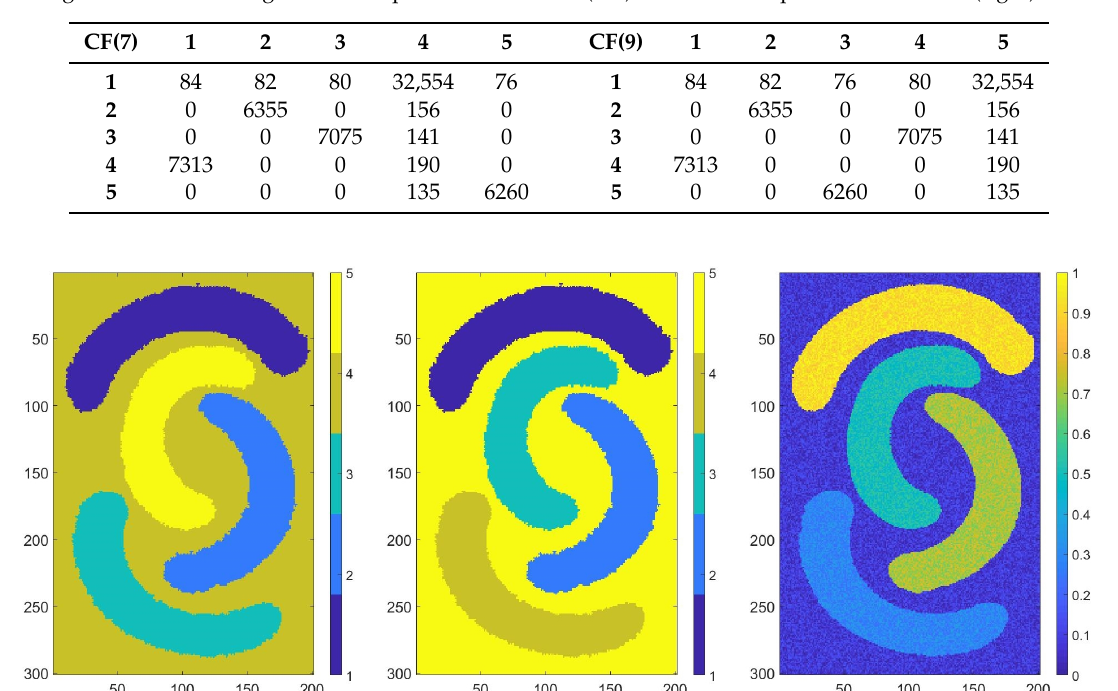
Table 2. The confusion matrices between the final classification of the entire dataset and the initially